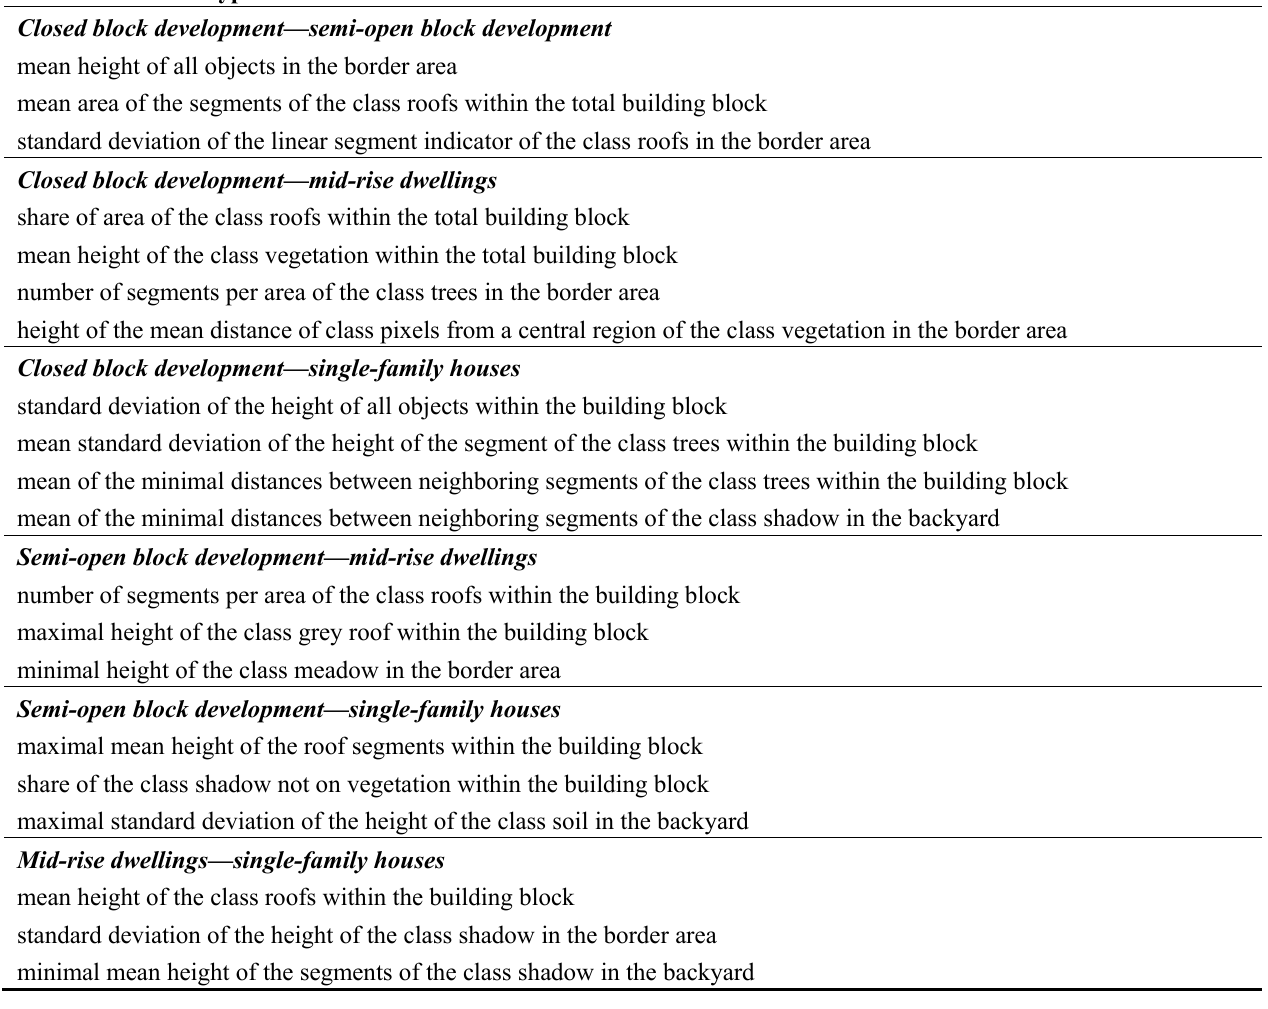
Table 2. Spatial features for pairwise distinction of urban structure types. Urban Structure Types and Features